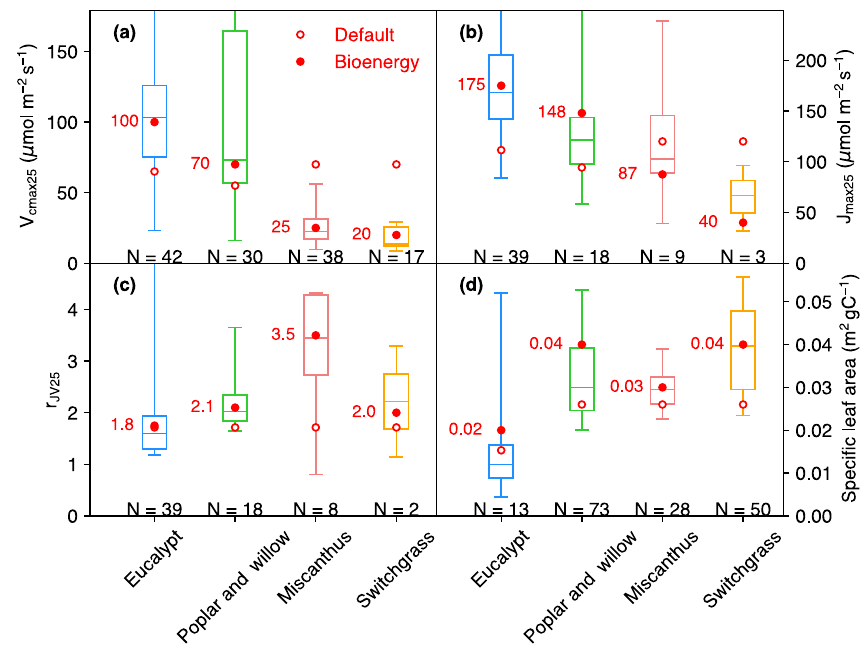
Figure 1. V cmax25 (a) , J max25 (b) , r JV 25 ( V cmax25 /J max25 , c ), and specific leaf area (SLA, d ) collected from measurements. The box plot indicates the interquartile range of measurements. The data size of measurements is shown below the box. The default values (open circles) and adjusted values (filled circles) for bioenergy crops are also shown. Because the model does not prescribe J max25 but rather calculates it from V cmax25 , the J max25 values for ORCHIDEE shown here (circles in b ) are calculated by V cmax25 × r JV (circles in a and b ).